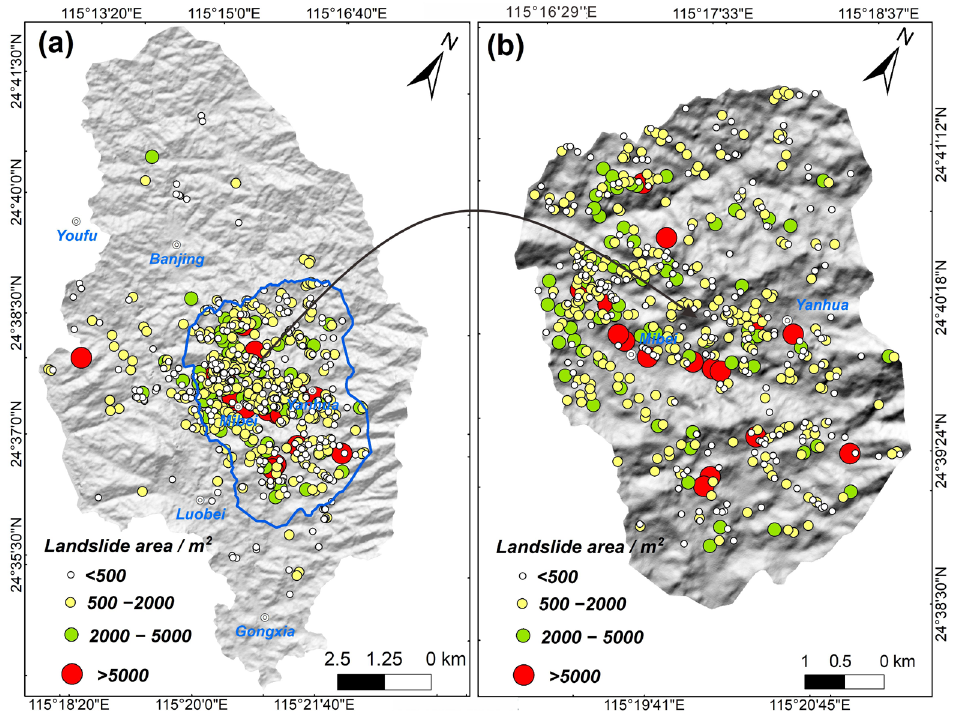
Figure 11. ( a ) Rainfall-induced landslide inventory of the 2019 heavy rainfall event in Longchuan County, the landslide abundance area of this event; ( b ) map showing the zooming of the landslide abundance area.